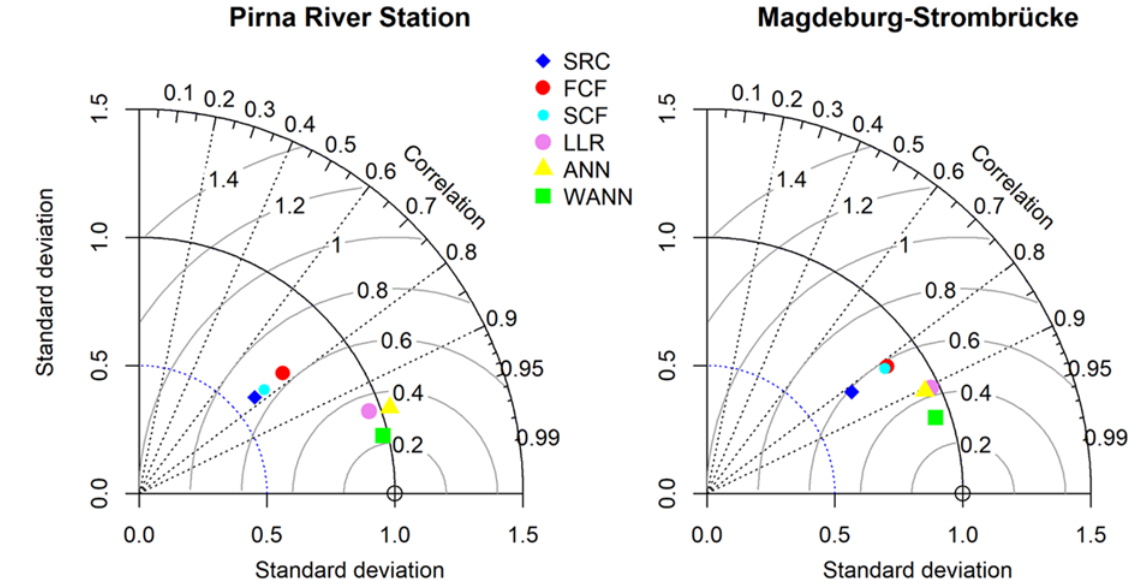
Figure 17. Comparison of different best models for the prediction of daily SSL by Taylor diagram. Table 9. Comparison of best models for the prediction of daily SSL.